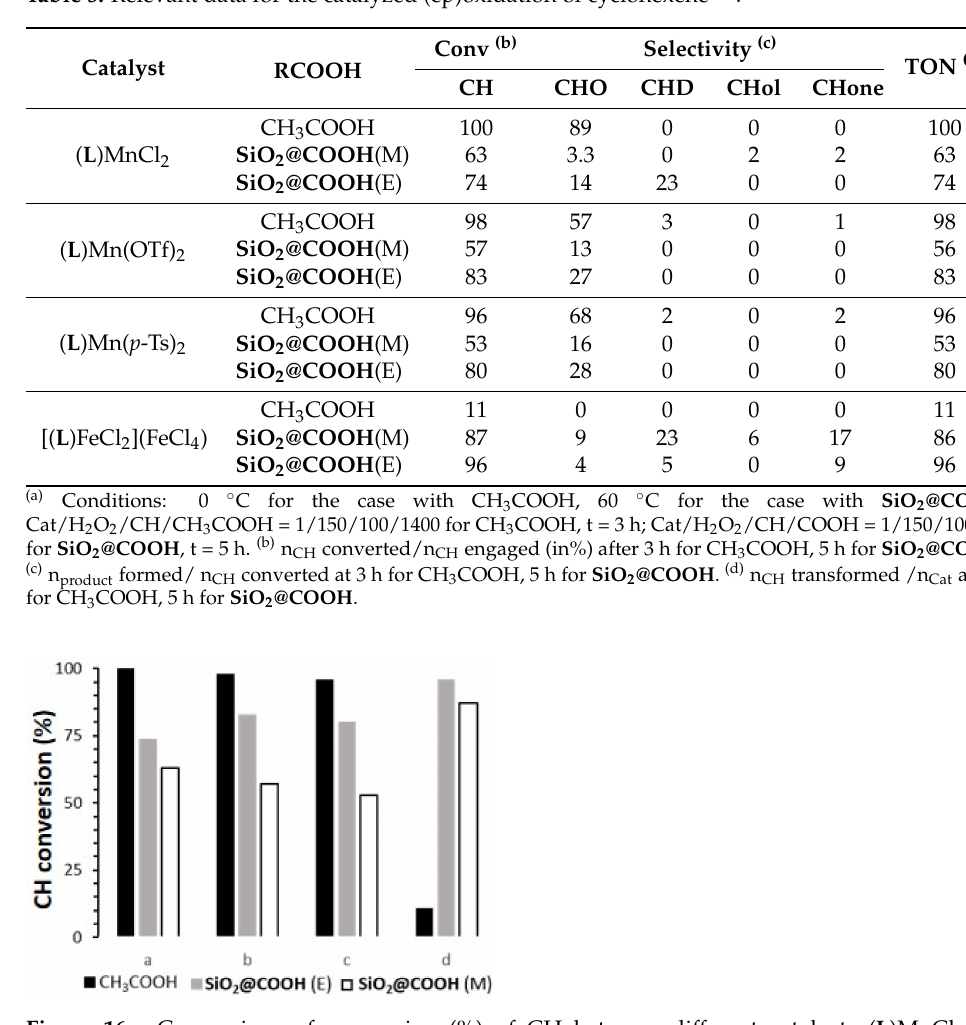
Figure 16. Comparison of conversion (%) of CH between different catalysts ( L )MnCl 2 ( a ), ( L )Mn(OTf) 2 ( b ), ( L )Mn( p -Ts) 2 ( c ), ( L )FeCl 2 (FeCl 4 ) ( d ) and different co-reagents. Reaction time: 3 h with CH 3 COOH, 5 h with SiO 2 @COOH